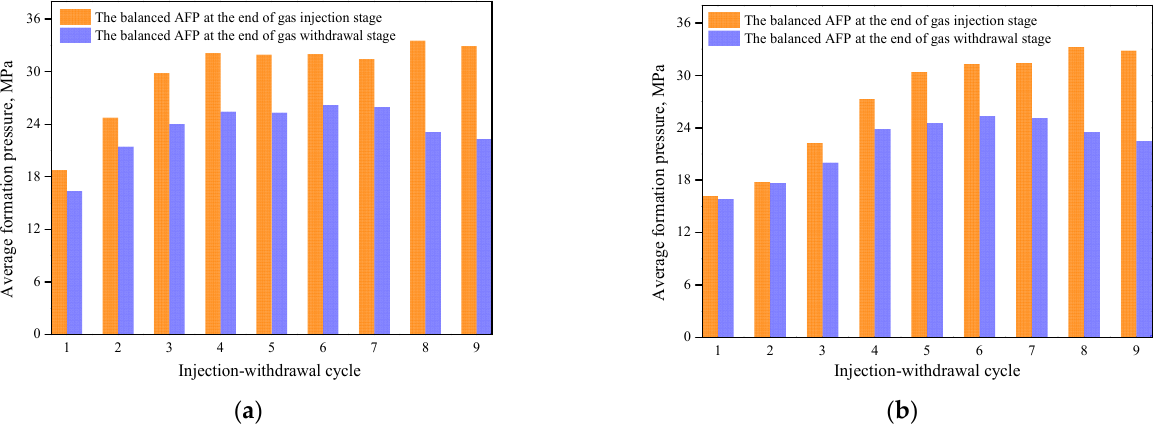
Figure 10. AFP variation trend in Hutubi UGS during nine injection − withdrawal cycles: ( a ) Zi I layer; ( b ) Zi II layer. Table 2. The deviation factor calculation results for Hutubi UGS during nine injection − withdrawal cycles.